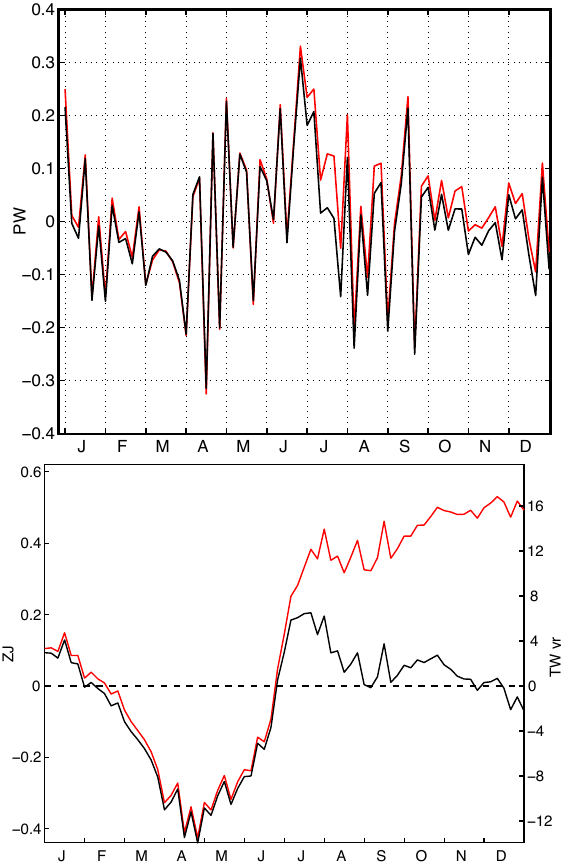
Fig. 5. Results for the northern region during model year 1994: (a) rate of change of heat content (black – calculated from the in- stantaneous datasets) and sum of the advection and diffusion terms (red – calculated from the 5-day mean datasets). Heat flux in PW (10 15 W). (b) Integrals over time of both terms. Heat content in ZJ (10 21 J), also shown as TW years.